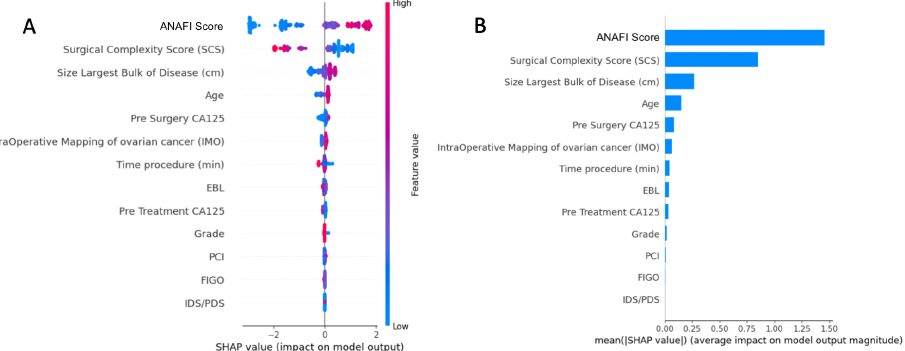
Figure 3. ( A ) Summary plot showing a set of beeswarm plots of feature distribution for global explain- ability of CC0 prediction, including the novel intra-operative disease score. ( B ) Feature importance bar plot description of SHAP values for the features included in the prediction. Dots correspond to the individual EOC patients. SCS, surgical complexity score; PCI, Peritoneal Carcinomatosis Index; IMO, Intra-operative Mapping for Ovarian Cancer; EBL, estimated blood loss; IDS, interval debulking surgery; PDS, primary debulking